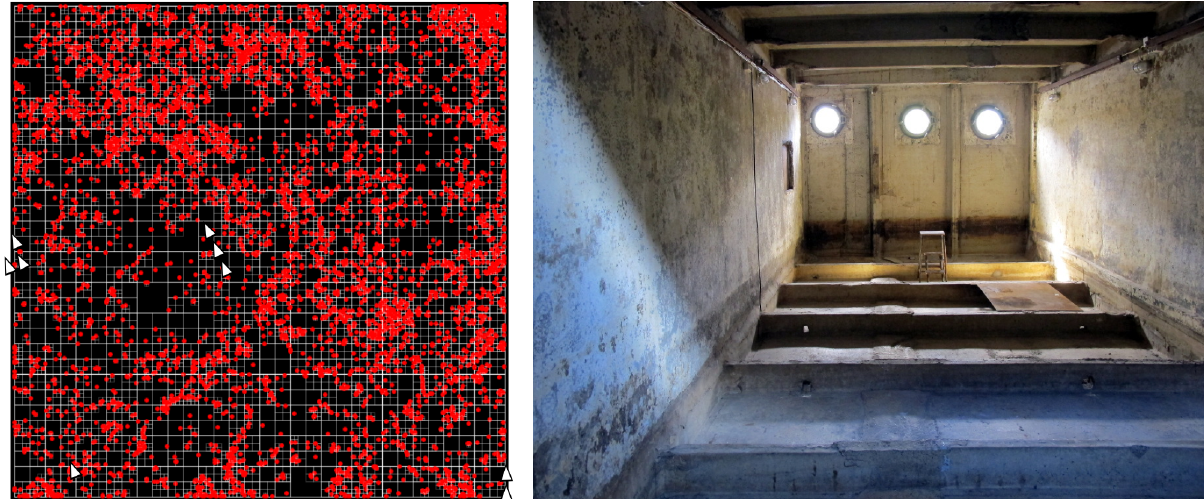
Figure 5 | Traversal of sounds (left) in Configuration (right). Each red dot is a sound synthesis graph obtained through GP and placed in the SOM. Superimposed is a swarm of nine agents scanning the map, each connected to a sound transducer in the